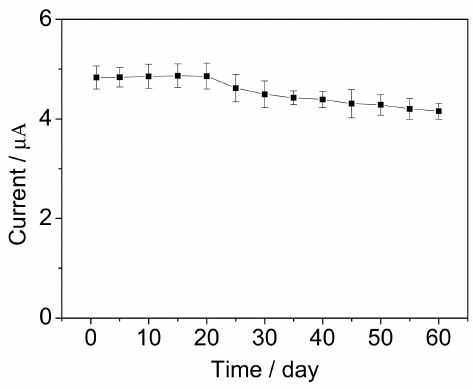
Figure 14. Long-term stability of the BOD biosensor. The error bars represent three replicate